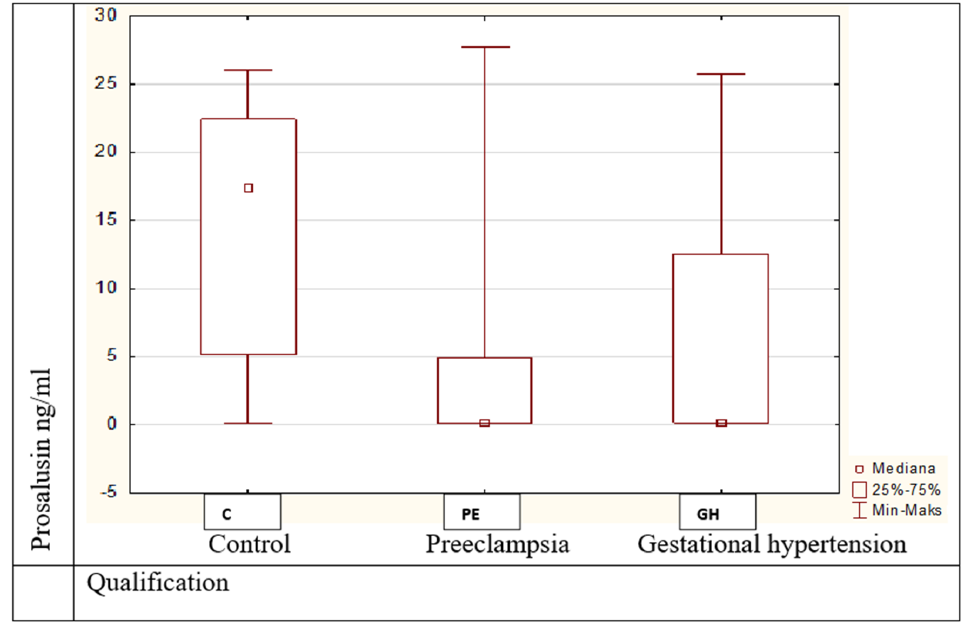
Figure 2. Prosalusin values between pregnant women in studied groups, p = 0.00001. (2). Salusin-alpha values were statistically significantly different (Kruskal–Wallis H = 11.43, p = 0.003) between patients with obesity and preeclampsia and those with gestational hypertension (Figure